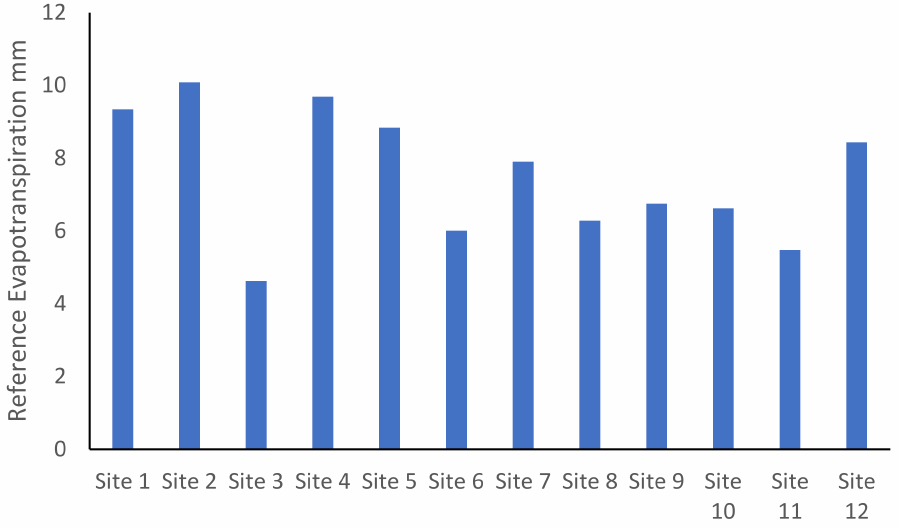
Figure 17. ET 0 values for selected